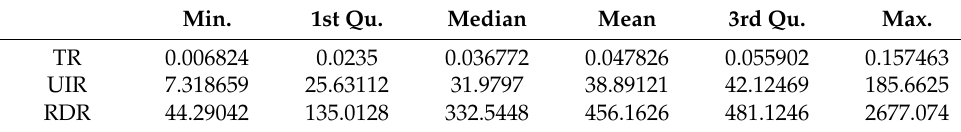
Table A2. Statistical Prescription of State Level Parameters on COVID-19. Min. 1st Qu. Median Mean 3rd Qu. Max.